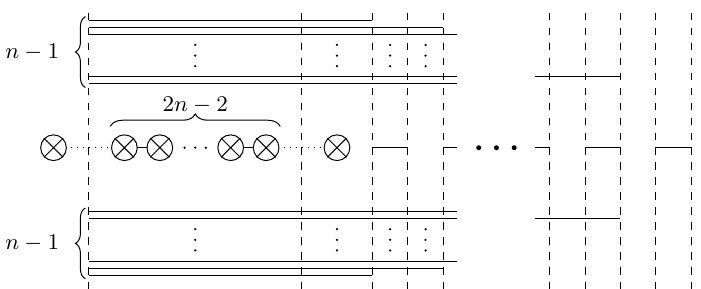
Figure 50. Higgs branch brane con(cid:12)guration for M H the closure of the maximal nilpotent orbit of so (2 n ). In the two leftmost intervals between half D5-branes there are n (cid:0) 1 D3-branes. The number of D3-branes then decreases by one on each next pair of intervals to the right, until it reaches zero.